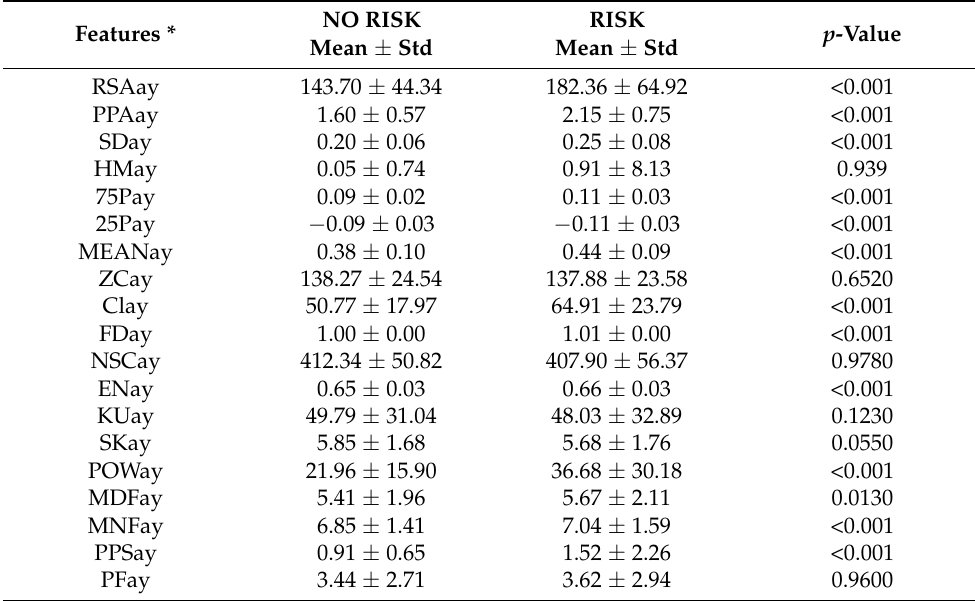
Table 5. Paired t -test NO RISK/RISK classes for each feature extracted from y -axis acceleration (ay). Features